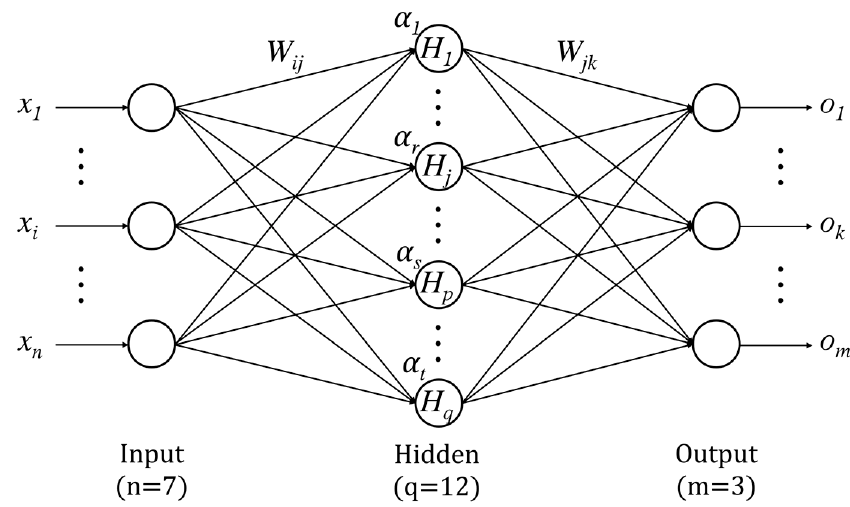
Figure 2. Graphical diagram of the 7 × 12 × 3 back propagation neural network (BPNN).